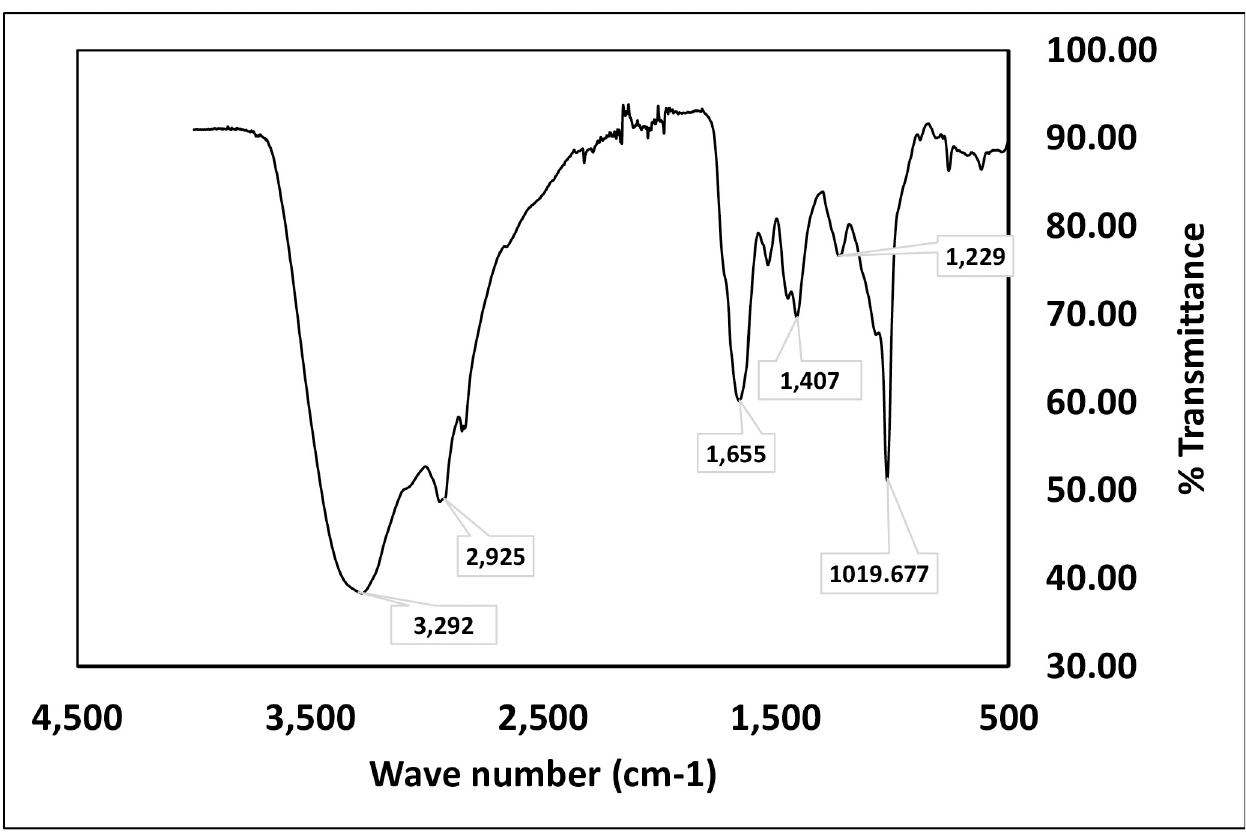
Fig 9. FTIR of biosurfactant produced by Gordonia sp. IITR